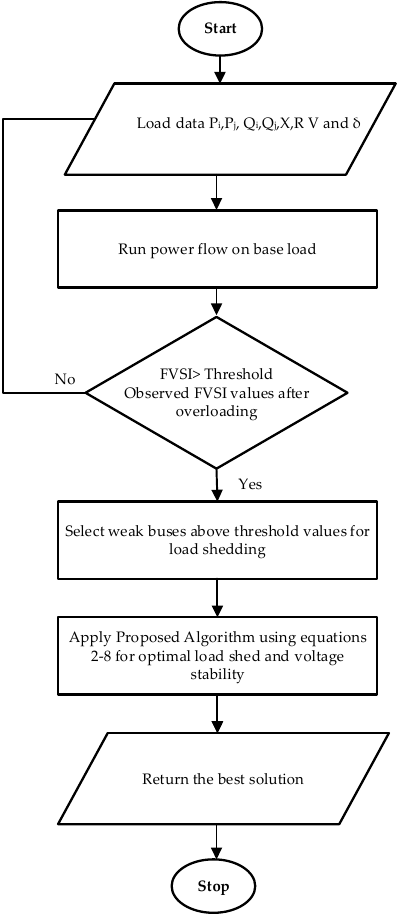
Figure 2. Flow chart of the proposed method.